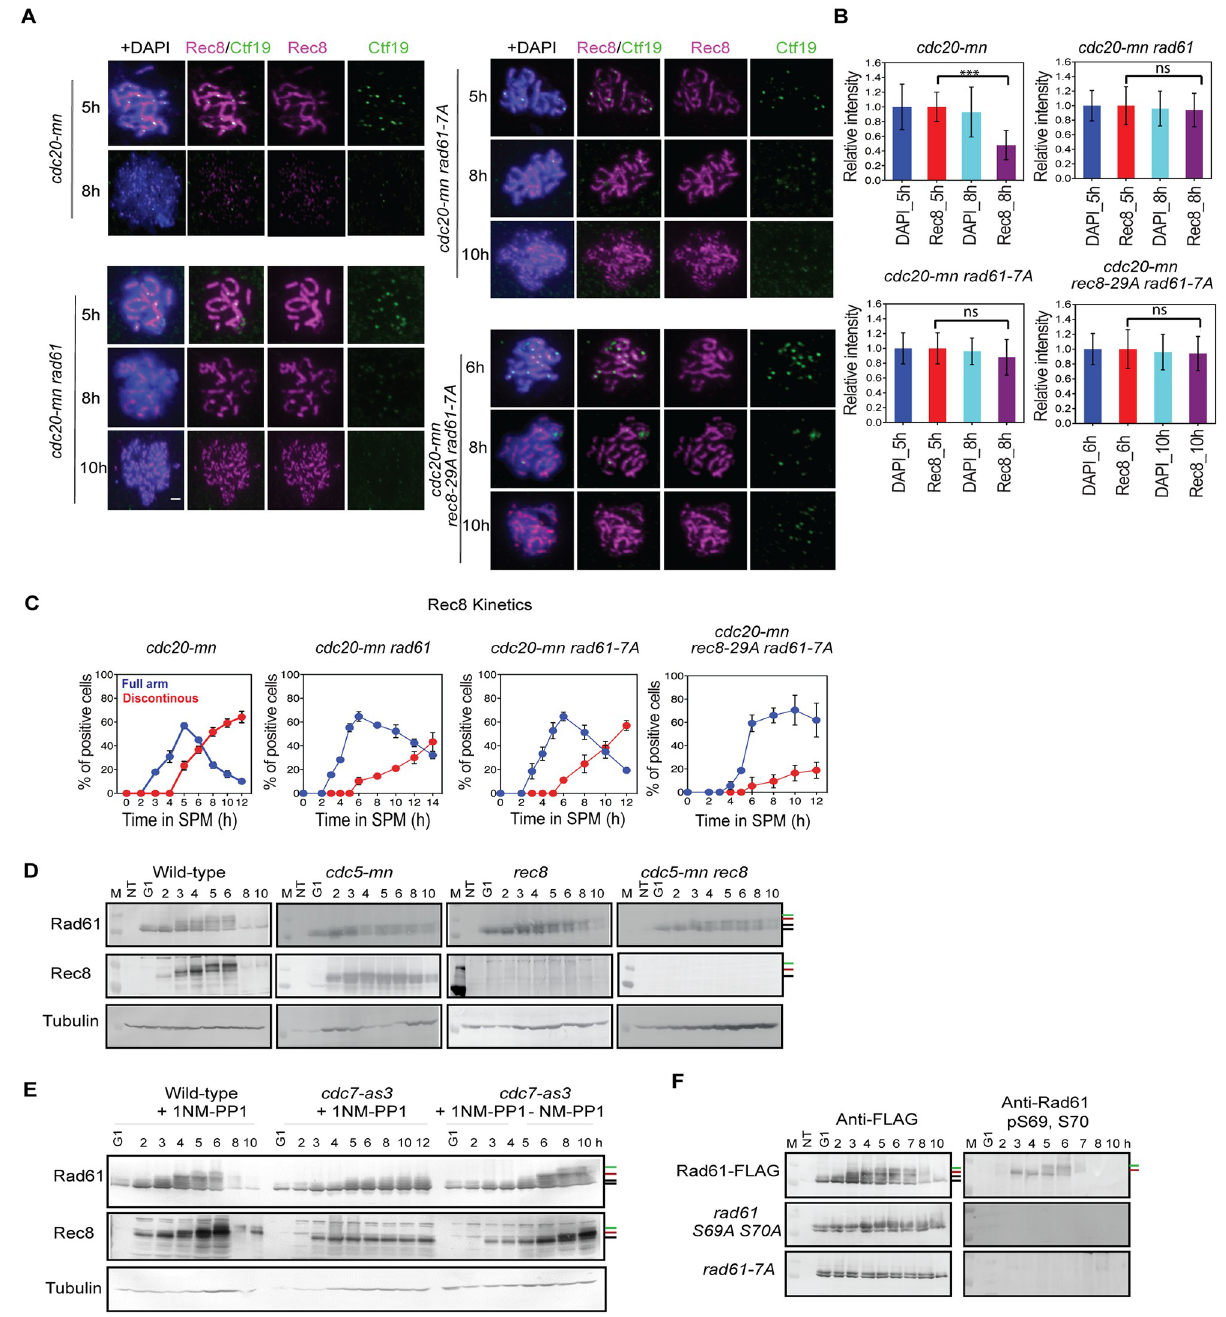
Fig 6. Rad61/Wpl1 plays a role in cohesin-release in late prophase-I. (A) Localization of Rec8 (red) and Ctf19 (green) in cdc20-mn (KSY642/643), cdc20-mn rad61 (KSY637/638), cdc20-mn rad61-7A (KSY653/654) and cdc20-mn rec8-29A rad61-7A (KSY1043/1044) cells. Representative image for each strain at various time points are shown. (B) Measurement of total Rec8 and DAPI signal intensity in (A) was analyzed in Fig 1C. Error bars show the S.D. (n = 3). (C) Kinetics of Rec8-classes was studied as described in Fig 1B. A minimum 100 cells were analyzed per time point. Error bars show the S.D. (n = 3). (D) Expression profiles of Rec8 and Rad61-Flag during meiosis were verified using RAD61-FLAG (KSY440/441), cdc5-mn RAD61-FLAG (KSY434/435), rec8 RAD61-FLAG (KSY627/628) and rec8 cdc5-mn RAD61-FLAG (KSY1092/1093) cells by western blotting. The protein positions are indicated with the lines on the right. The positions of Rec8 and Rad61-Flag are shown by bars. Black bars indicate non-phosphorylated Rad61 or Rec8. Red and green bars are DDK-dependent and PLK/Cdc5-dependent phosphorylated Rad61 or Rec8, respectively. (E) Bands shits of Rec8 and Rad61 were analyzed in presence and absence of PP1 in RAD61-FLAG (KSY440/441) and cdc7-as3 RAD61-FLAG (KSY978/979) strains at the indicated time points by western blotting as shown in (D). PP1 was added at 0 h in three cases and washed out at 5 in the right panel. (F) The western blotting analysis was carried out for Rad61-Flag (Right) and Rad61-pS69, 70 (left) in RAD61-FLAG (KSY440/441), rad61-S69A , S70A-FLAG (KSY754/757) and rad61- 7A-FLAG (KSY753/755) strains as shown in